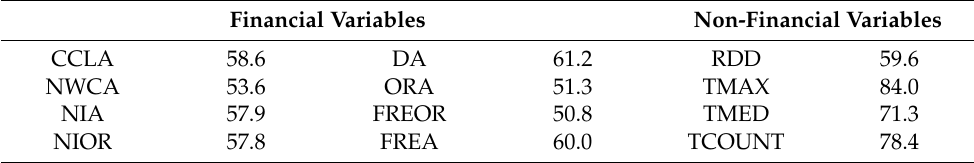
Table 7. Univariate prediction accuracies of variables